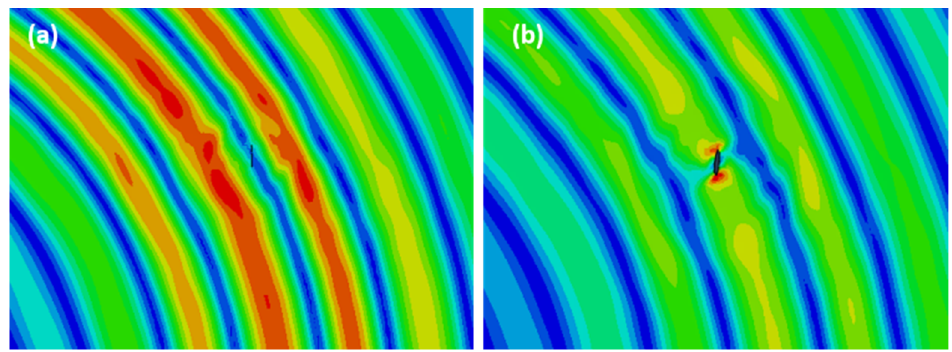
Figure 10. Snapshots of Lamb waves traversing a breathing crack in modeling: ( a ) stress traversing when the crack was closed ( b ) stress being blocked when the crack was open.